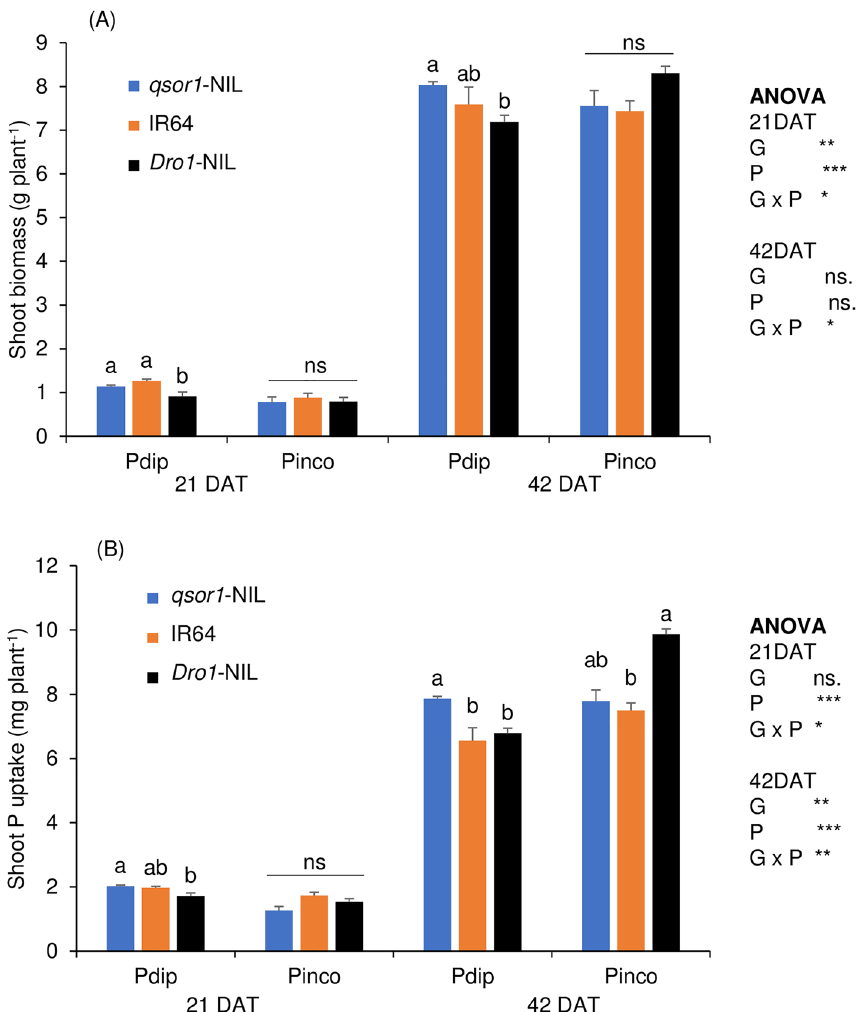
Figure 1. Shoot biomass ( A ) and shoot P uptake ( B ) of rice genotypes as affected by different P application methods (P incorporation (P inco ) of 500 mg P 2 O 5 box −1 vs. P-dipping (P dip ) of 90 mg P 2 O 5 box −1 ) at 21 days after transplanting (DAT), and 42 DAT. Different letters and ns within each treatment indicate significant and non- significant differences, respectively, among genotypes at 5% using Tukey’s HSD test. Error bars represent the standard error of replications. The *, **, and *** indicate that the individual effects of and interaction between genotype (G) and P application method (P) are significant at P < 0.05, P < 0.01, and P < 0.001,